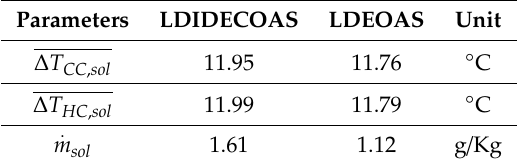
Table 6. Values of the desiccant solution in the LD system.